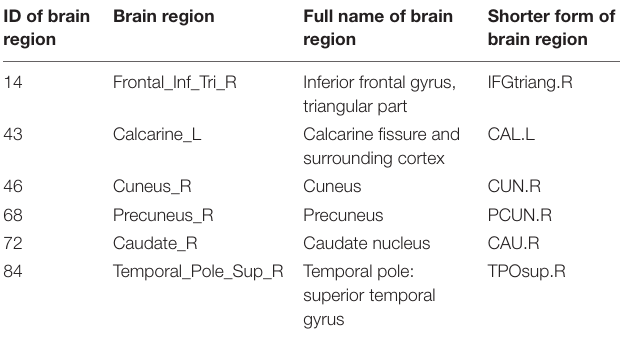
TABLE 4 | The brain regions with a frequency of 9.